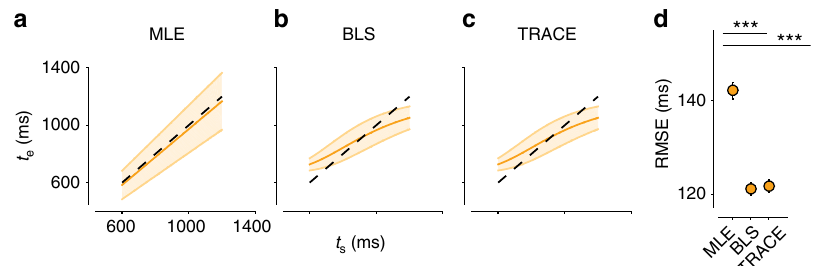
Fig. 2 Bayesian estimation by TRACE. a The maximum likelihood estimator (MLE). The plot shows the mean (orange line) and standard deviation (shaded area) of interval estimates ( t e ) derived from MLE as a function of the sample interval ( t s ) in the RSG task. MLE provides accurate estimates on average (orange line close to the unity dashed line), but the standard deviation of t e is relatively large and increases with t s . b The Bayes-Least-Squares (BLS) estimator. BLS estimates are biased away from t s and toward the mean of the prior but are substantially less variable (smaller shaded region). c The output of TRACE. TRACE behaves in a manner similar to BLS. d Root-mean-square error (RMSE) between t e and t s for MLE, BLS, and TRACE. Both BLS and TRACE outperformed MLE (paired t -test BLS-MLE RMSE: t 1998 = 739, p (cid:3) 0.001 TRACE-MLE: t 1998 = 731, p (cid:3) 0.001). Asterisks indicate p (cid:3) 0.001. Error bars indicate standard deviation across runs of RMSE calculated over all sample intervals